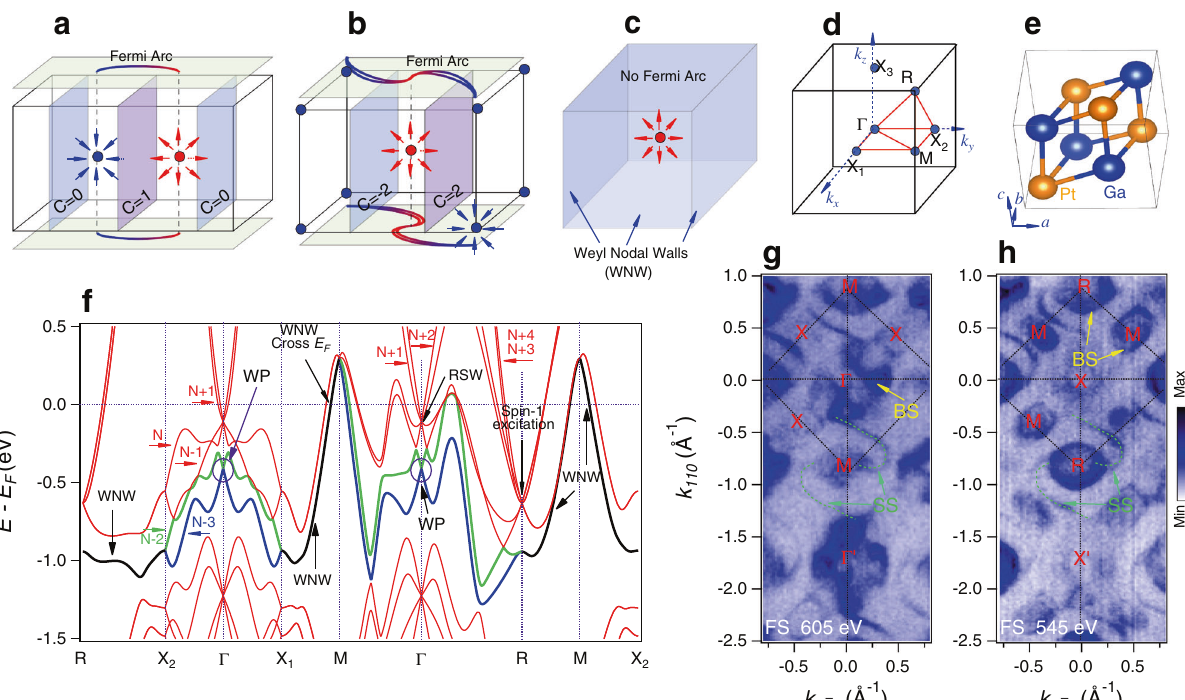
Fig. 1 Weyl semimetal (WSM) schematic with paired points and unpaired points. a A conventional WSM restricted by the no-go theorem with surface Fermi arcs surface states connecting the projections of the bulk WPs with opposite chirality on the surface BZ. “ C ” indicates 2D Chern number on the related slice. b The topological semimetal system containing both spin-3/2 RSW (Rarita – Schwinger – Weyl) and spin-1 Weyl points at different high- symmetry points in the bulk BZ and the large surface Fermi arcs connecting the projections of these WPs on the surface BZ. c Schematic drawing of a topological semimetal with a single Weyl point in the BZ center enclosed by the topologically charged Weyl nodal walls (WNWs) on the BZ boundaries. No surface Fermi arc connects the projection of this singular WP. d , e 3D bulk BZ and unit cell of PtGa single crystal, respectively. f Bulk band structure of PtGa along the high symmetry lines as indicated in d . The green and blue lines are the nondegenerate bands that cross at the BZ boundary forming the topologically charged double degenerate WNWs (black lines). The circles indicate the singular Weyl point in the center of the BZ. g , h The Fermi surface maps, acquired by ARPES measurements with photon energies hv = 605 and 545 eV, respectively. Labels BS and SS denote bulk and surface states, Figure 1g, h show the Fermi surface (FS) maps acquired in the Γ – M – X and X – R – M planes, respectively. Large Fermi arcs connecting the projections of the R (double Weyl node) and Γ (RSW node) points are clearly observed associated with bands N − 1 to N + 4. These are indicated by dotted green lines and labeled “ SS. ” The Fermi arcs are furthermore illustrated schematically in Fig. 1b, which have been investigated in the previous report 28 .